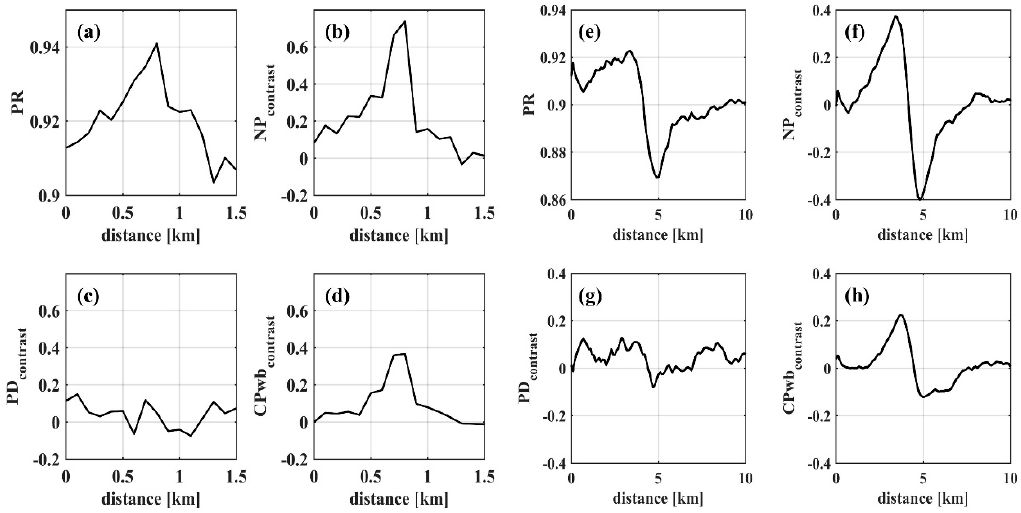
Figure 10. Transects across the current along the red arrow shown in Figure 9: ( a ) PR, ( b ) NP contrast, ( c ) PD contrast, ( d ) CPwb contrast. Transects across the current along the blue arrow shown in Figure 9: ( e ) PR, ( f ) NP contrast, ( g ) PD contrast, ( h ) CPwb contrast.